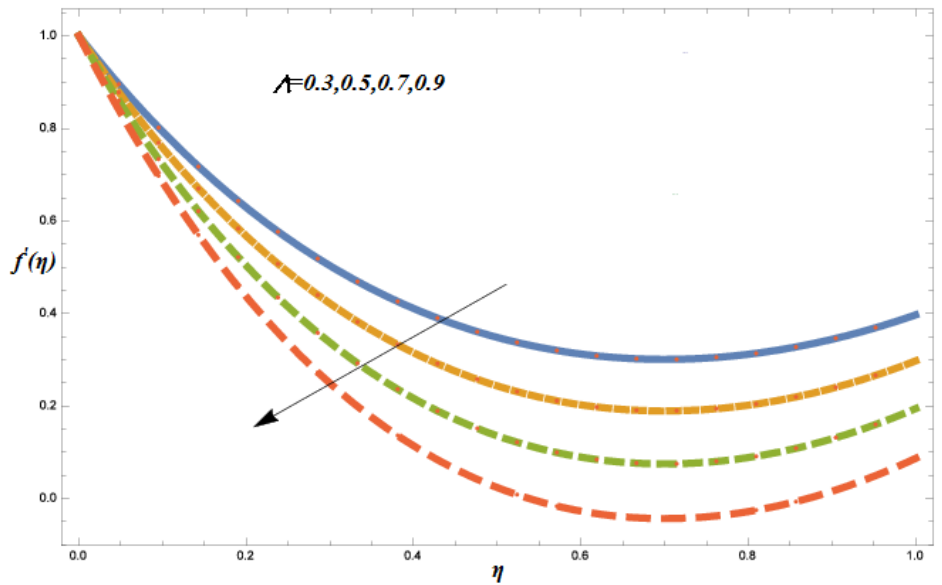
Figure 18. Variations in concentration field ( )   occur for different values of S = 0.7, B r = 0.7, N r = 0.7, P r = 10, S r = 0.7, ε = 0.7, D u = 0.7, λ = 0.7, Λ = 0.7, β = 1.